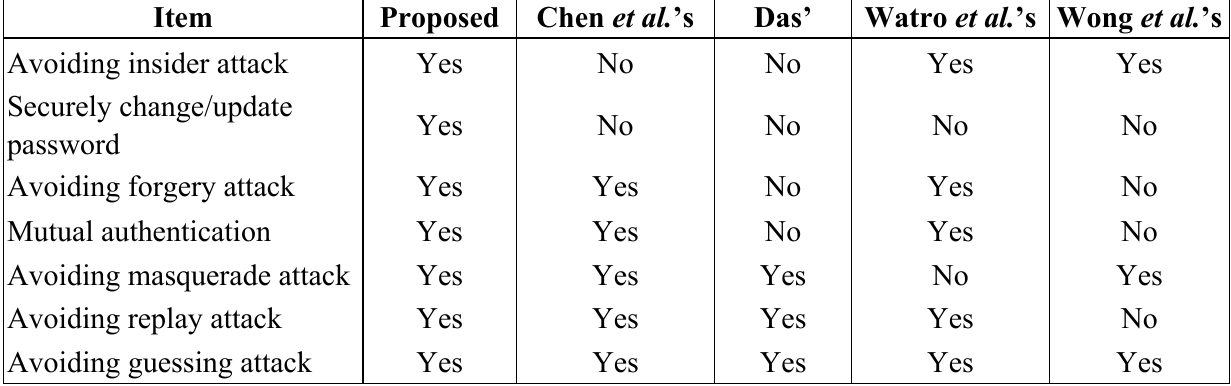
Table 2. Security comparison among the referenced